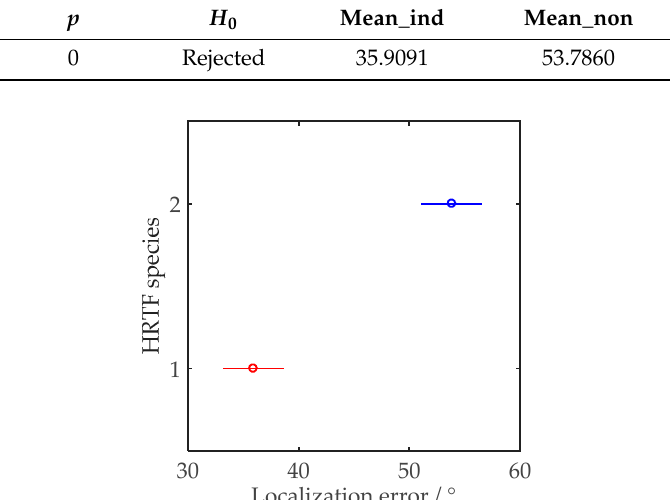
Table 9. Post-hoc for two-way repeated ANOVA. Mean_ind and mean_non denote the mean localization errors of the individualized HRTFs and the non-individualized ones, respectively.